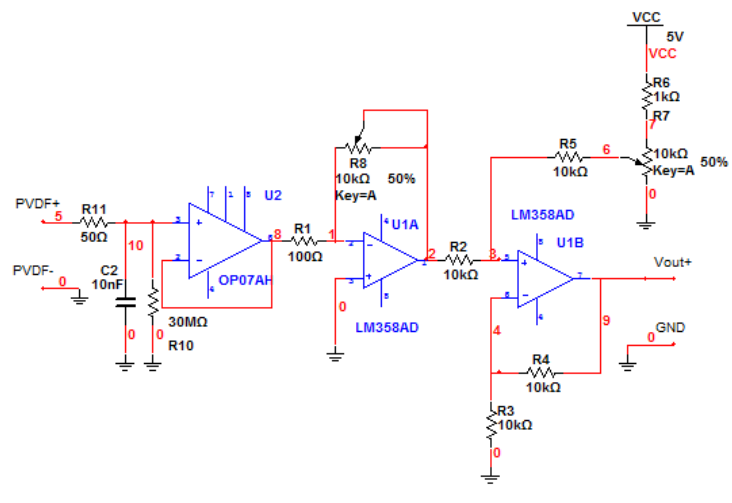
Figure 17. Pre-processing circuit of the unit of the PVDF sensor.